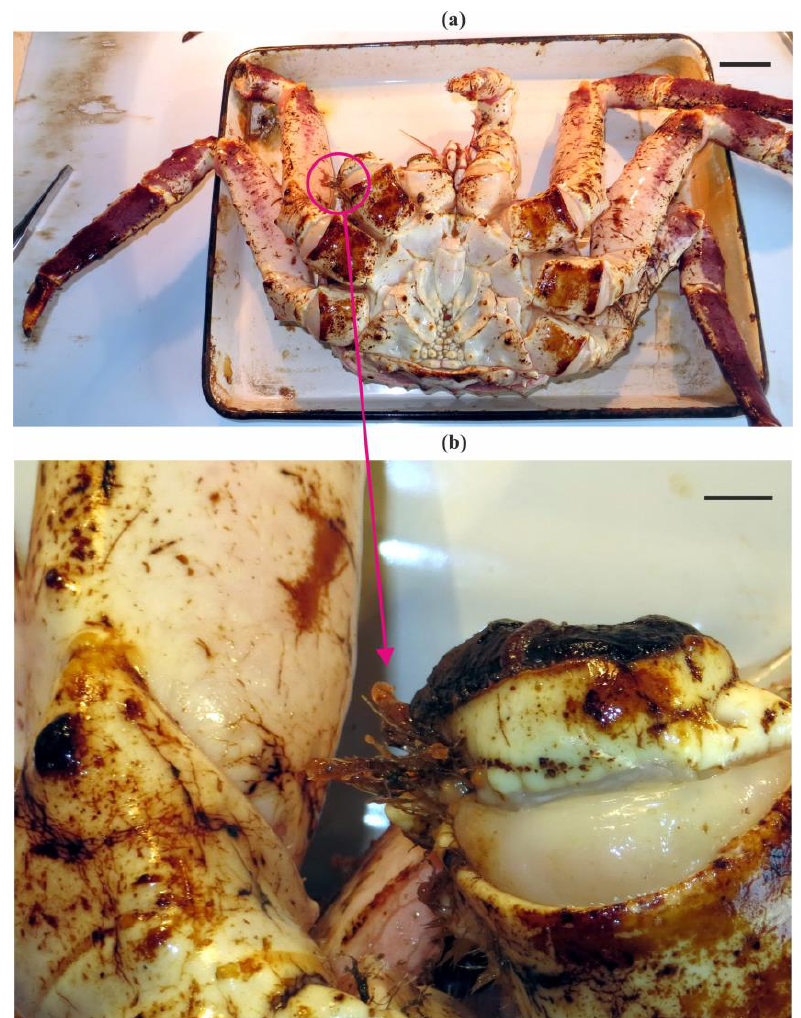
Figure 2. Coryne hincksi on the membrane at the plane of severance of an autotomized limb of a male red king crab, Paralithodes camtschaticus. Zelentskaya Bay, Barents Sea, July, 2022. ( a ) scale bar 50 mm, ( b ) scale bar 10 mm. Photo by Dvoretsky, V.G.